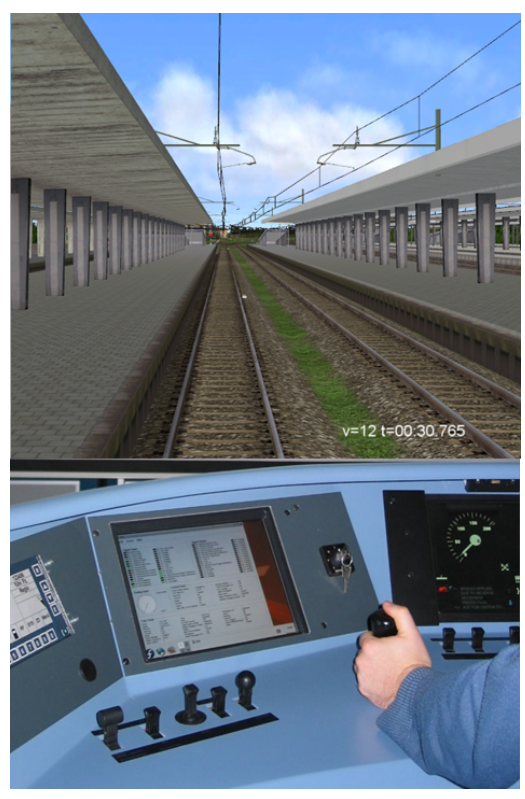
Figure 8: Virtual railway reference track in a simulation setup in DLR RaiSET.